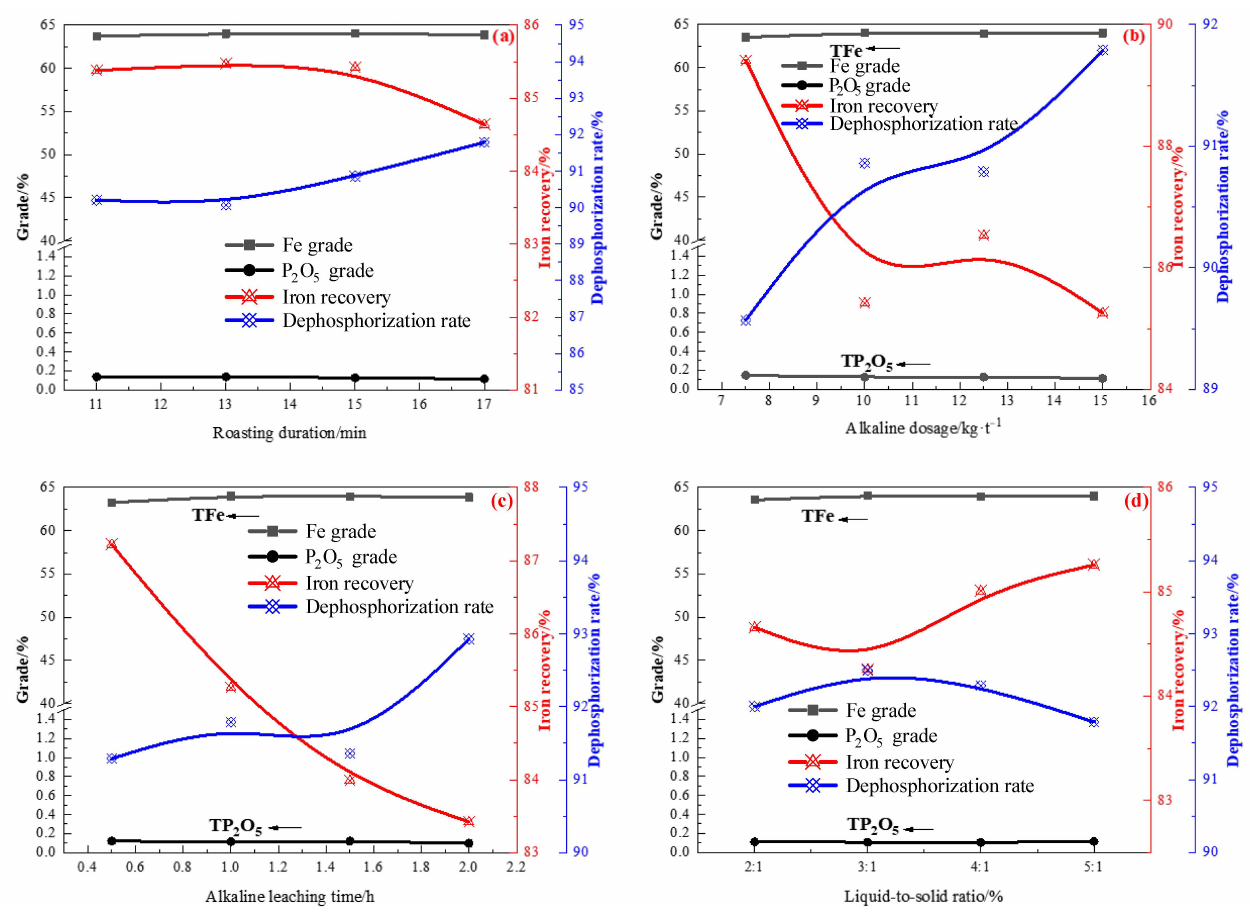
Figure 12. Effects of roasting duration and alkaline leaching conditions on the indices. ( a ) roasting duration; ( b ) alkaline dosage; ( c ) alkaline leaching time; ( d ) liquid-to-solid